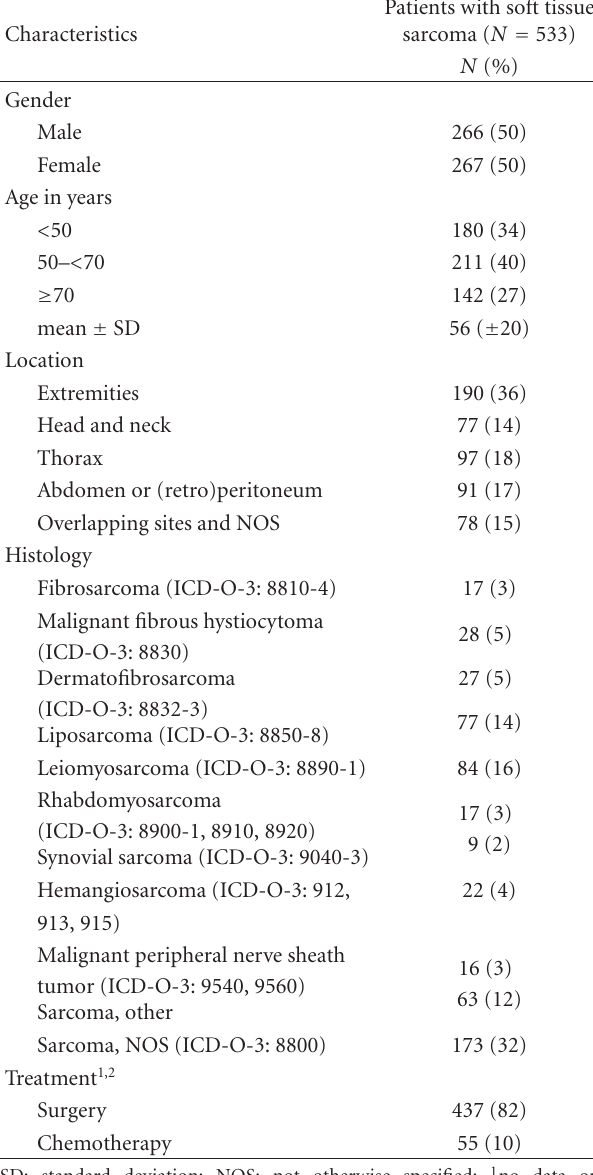
Table 1: Characteristics of newly diagnosed patients with soft tissue